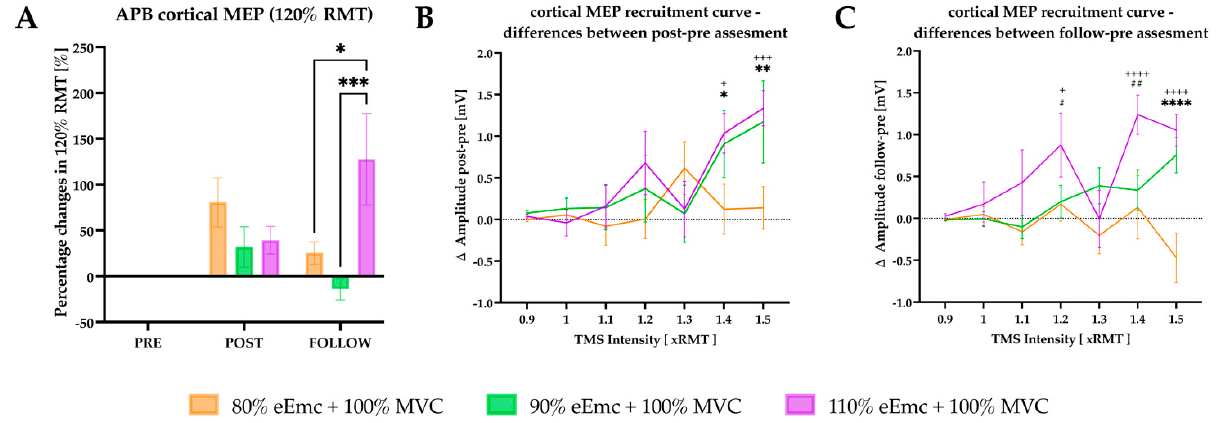
Figure 4. Cortical excitability outcomes. ( A ) percentage changes in cortical MEP evoked by TMS 120% of RMT with respect to baseline. Intervention simple effect showed significant differences at follow of 110% eEmc with respect to 80% (* p = 0.0126) and 90% eEmc (*** p = 0.0005); ( B ) difference in cortical MEP amplitude between post and pre time points. Intensity simple effects showed significant differences of 80% eEmc with respect 90% and 110% of eEmc at 1.4 (* p = 0.0390, + p = 0.0133) and 1.5 (** p = 0.0042, +++ p = 0.0008) RMT cortical MEP; ( C ) difference in cortical MEP amplitude between follow and pre time points. Intensity simple effects showed significant differences of 80% and 110% eEmc at 1.2 ( + p = 0.0162), 1.4 ( ++++ p < 0.0001) and 1.5 RMT ( ++++ p < 0.0001); and of 90% and 110% eEmc at 1.2 ( # p < 0.0225) and 1.4 RMT multiple ( ## p = 0.0015); and of 80% and 90% eEmc at 1.5 (**** p < 0.0001) RMT multiple.